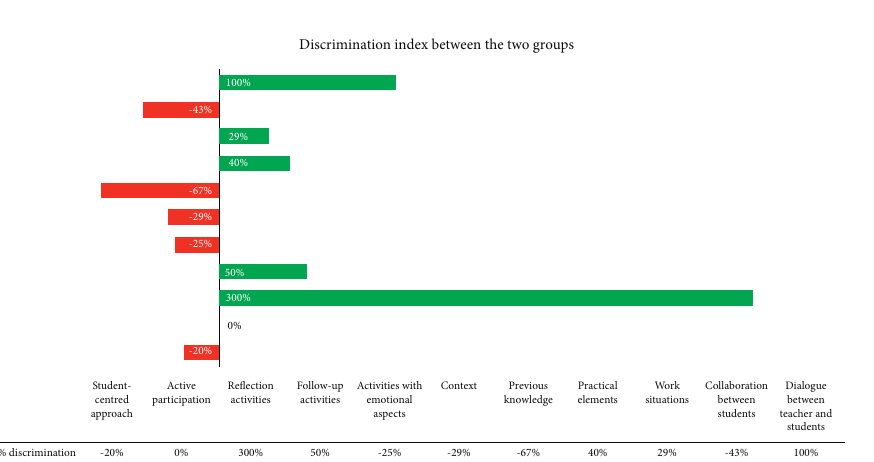
Figure 5: Graph of the percentage discrimination between categories for the two